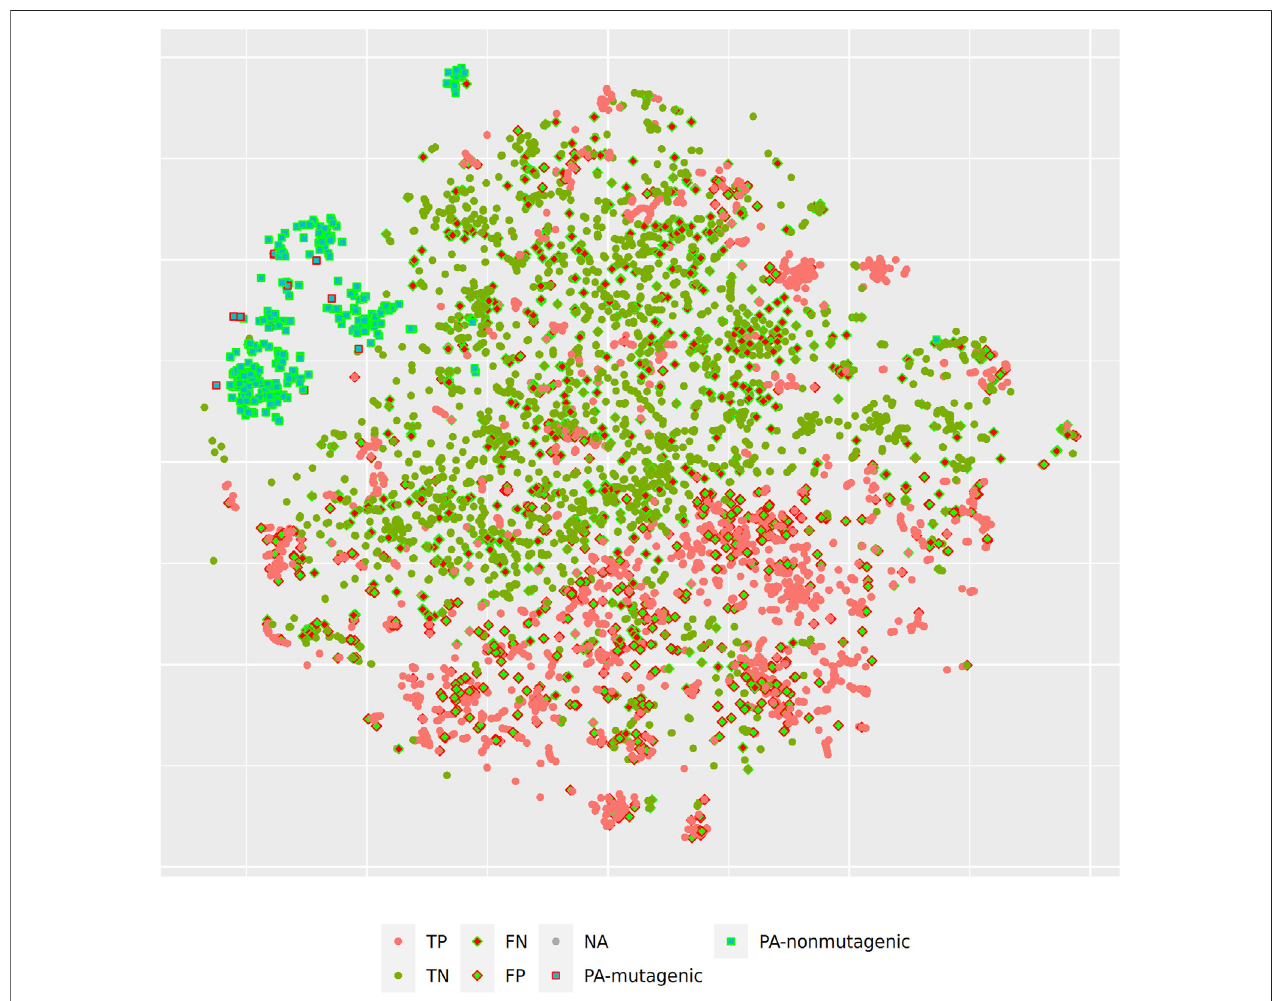
FIGURE 5 | t-SNE visualization of MP2D random forest